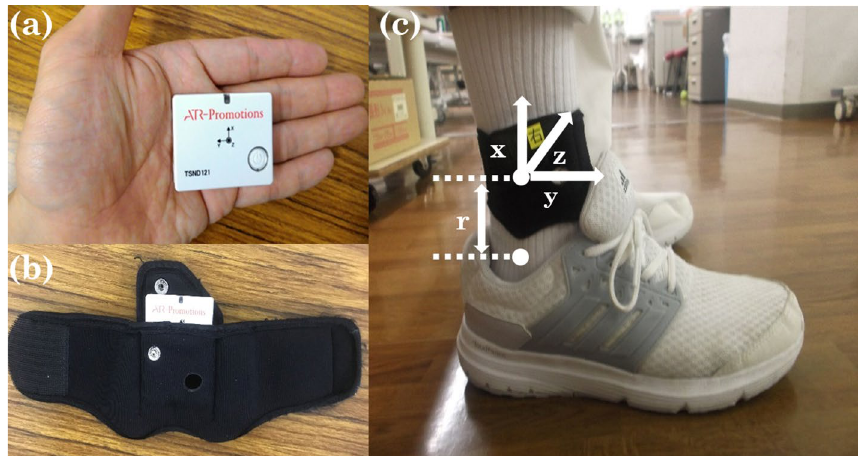
Figure 1. Configuration of the IMUs. ( a ) The IMU with the accelerometer and gyroscope. ( b ) The special band for wearing the IMU on the shank. ( c ) The position and coordination of the IMU. Two IMUs are attached to the shank just above the malleolus at a distance of r. IMUs are attached to the shank in the position 0.03 m above the malleolus. The axes x, y, and z are the coordinate system of the IMU, where the z-axis is perpendicular to the sagittal plane formed by the y and